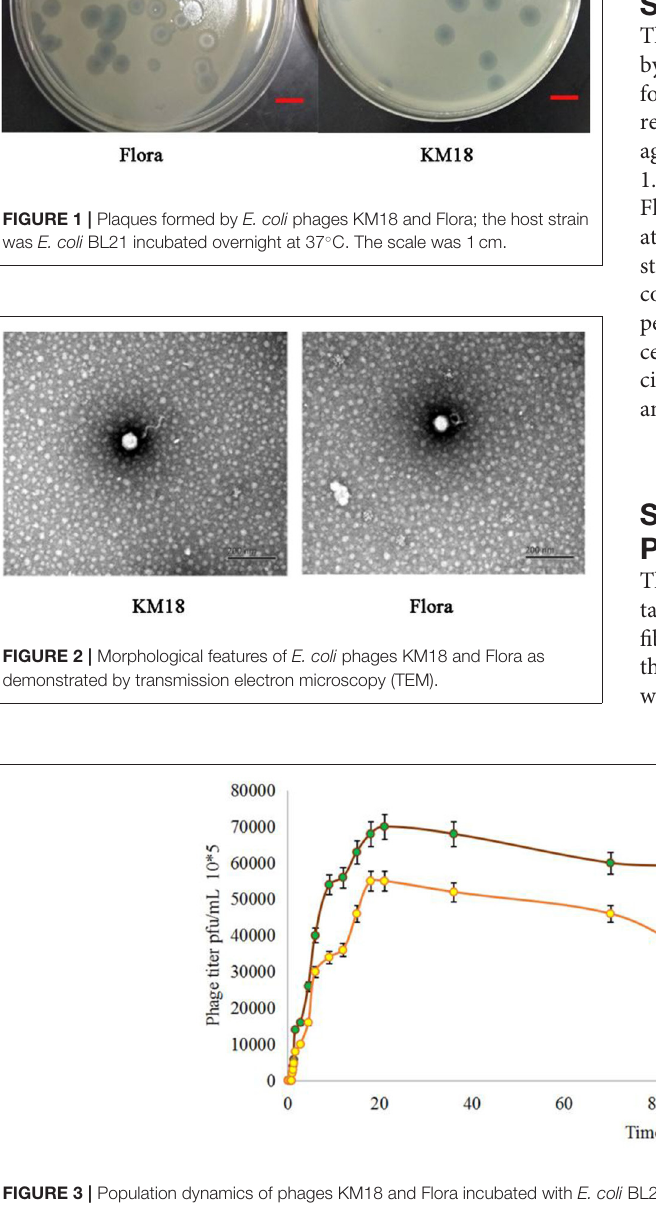
Frontiers in Veterinary Science |